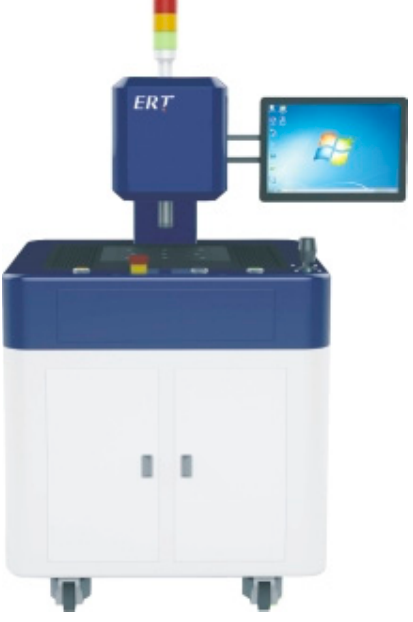
Figure 3. The fixed-base surface profilometer (ST150) used in this study (Nanovea Company, Irvine, USA).